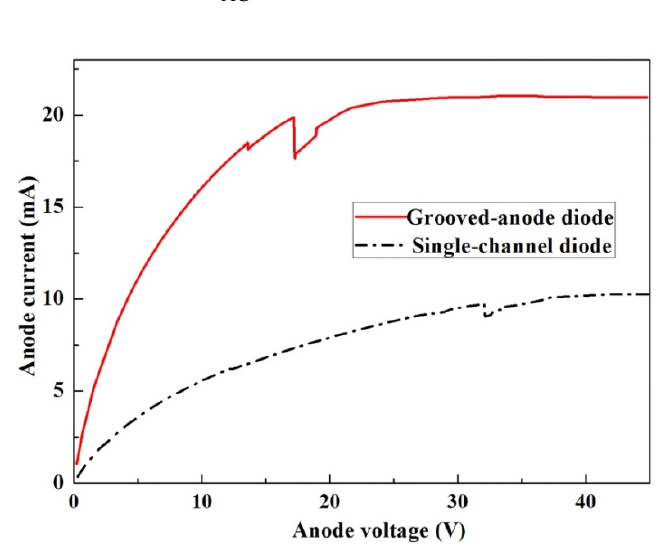
Figure 4. DC I-V output for the grooved-anode diode and single-channel diode as L = 2.0 µm. Micromachines 2020 , 11 , x FOR PEER REVIEW